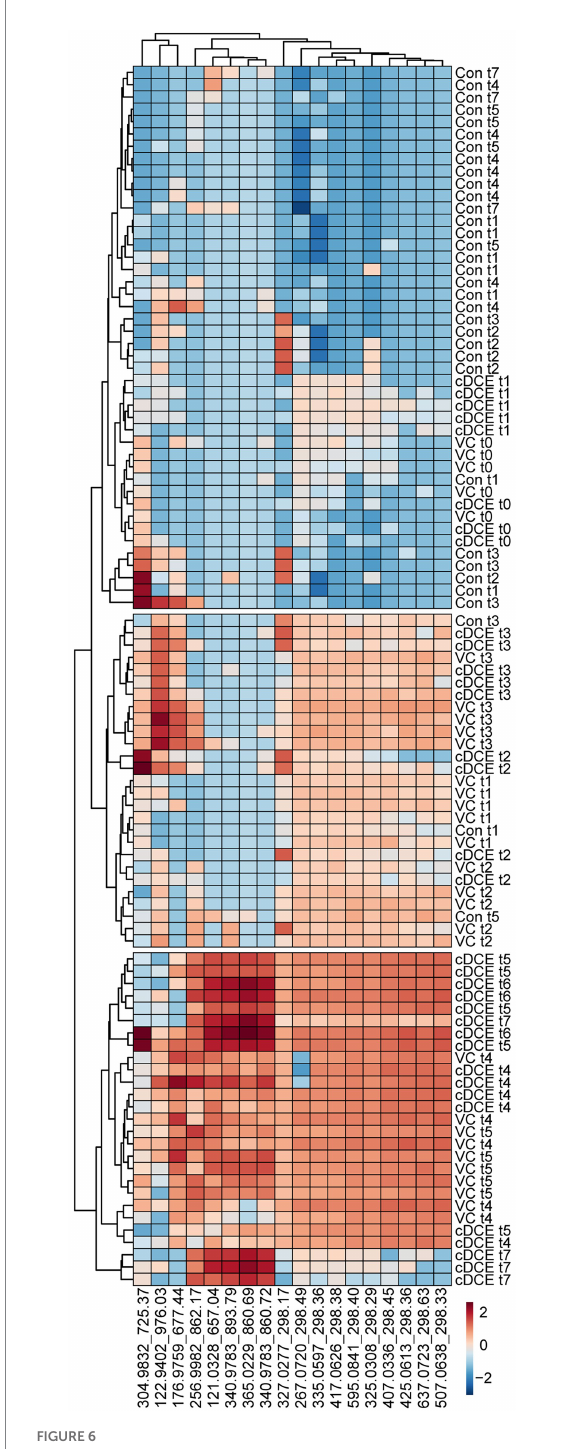
FIGURE 6 Correlation heatmap of 18 identified biomarkers. Log 10 transformed metabolomics data are able to differentiate among dechlorination status and time